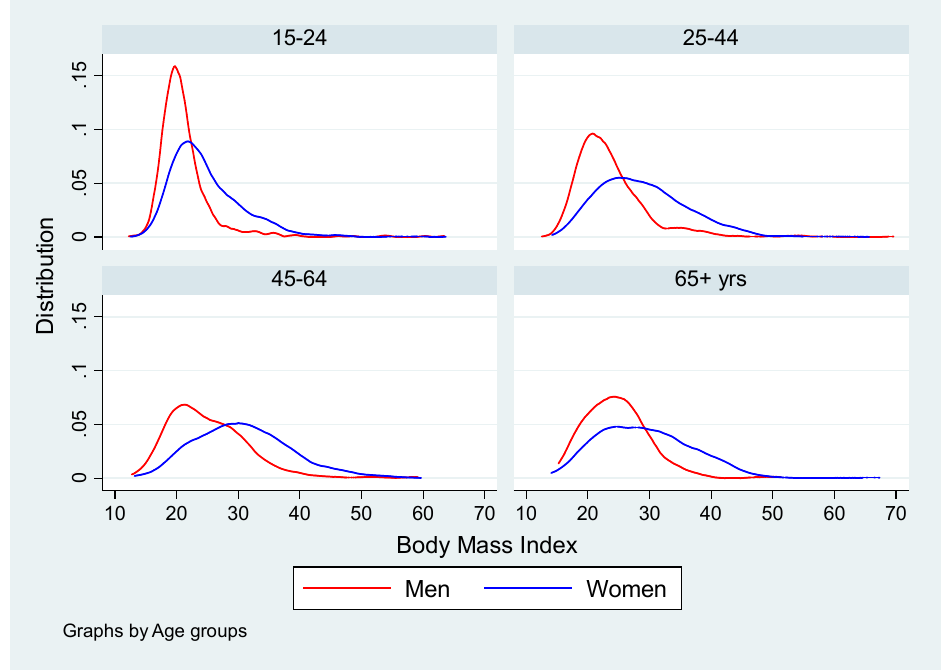
Figure 1. Distribution (kernel density) of body mass index (in percentiles and kilograms per square meters) among 2254 men and 4170 women from the first South African National Health and Nutrition Examination Survey (SANHANES-1) study in South Africa in 2012; by age group.